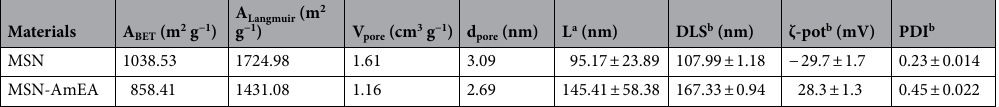
Table 1. Textural properties of MSN and MSN-AmEA, including BET and Langmuir surface area, pore volume, pore diameter, average particle size (L) measured by SEM, hydrodynamic particle size by DLS method, zeta (ζ) potential, and polydispersity index (PDI). a Average particle size (L) was calculated using SEM images. b Measured under PBS solution pH 7.4.